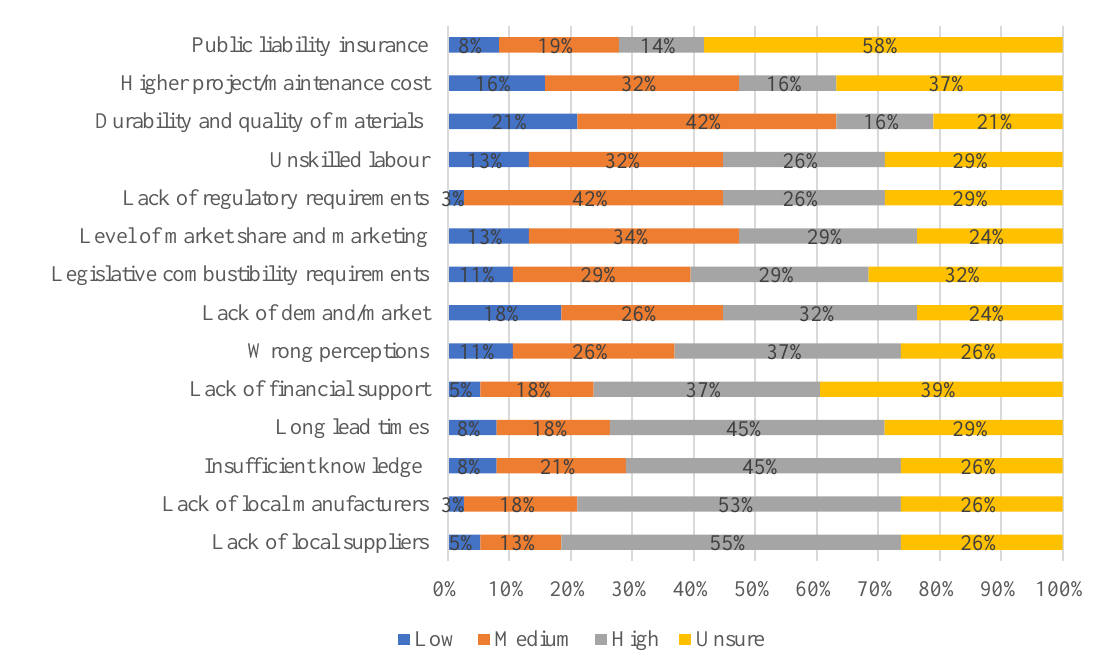
Figure 6. Main barriers to widespread acceptance of MTC.